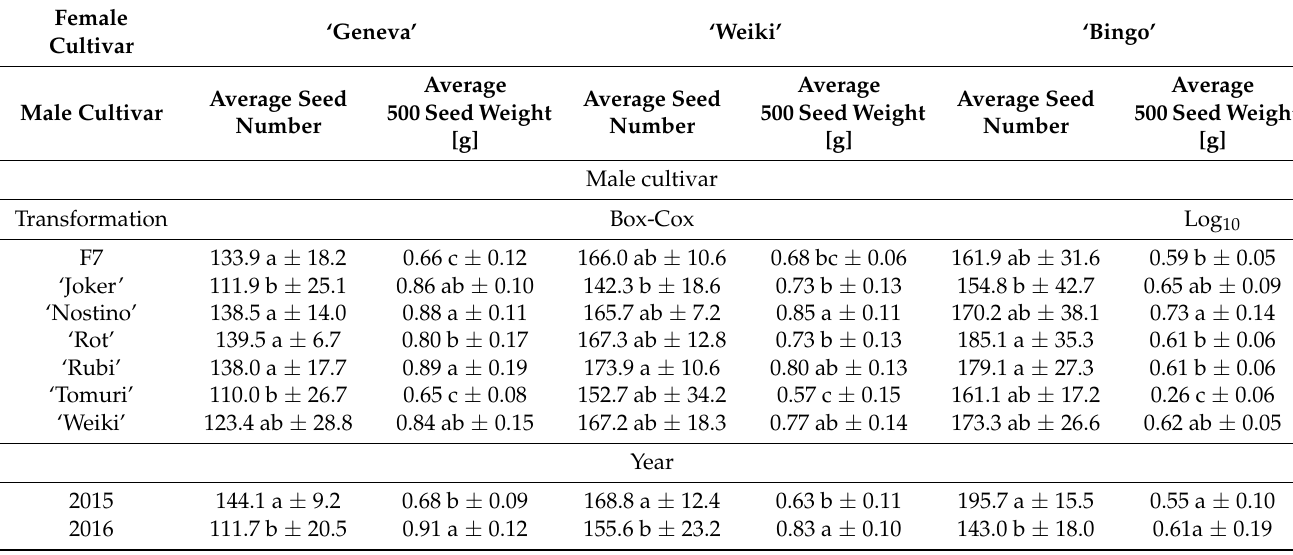
Table 5. Basic seeds parameters gained in different pollination combinations (data represent mean ±